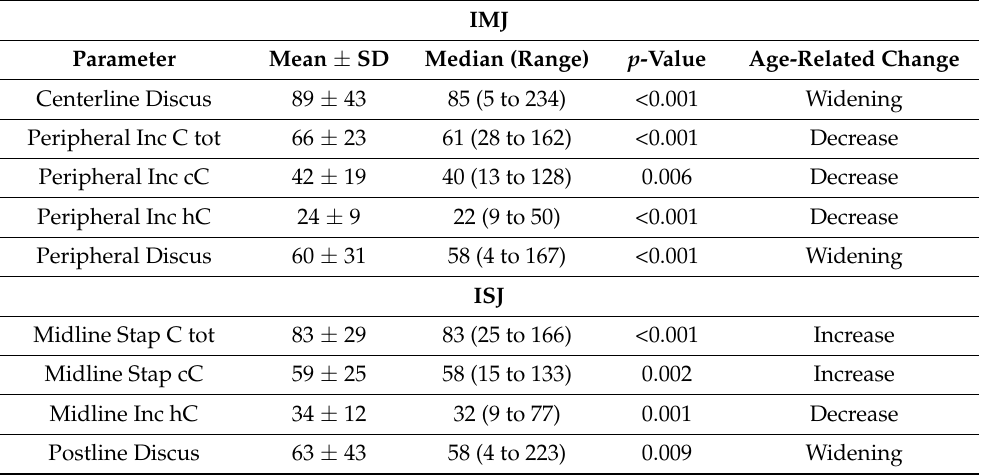
Table 2. Significant histological findings of the IMJ and